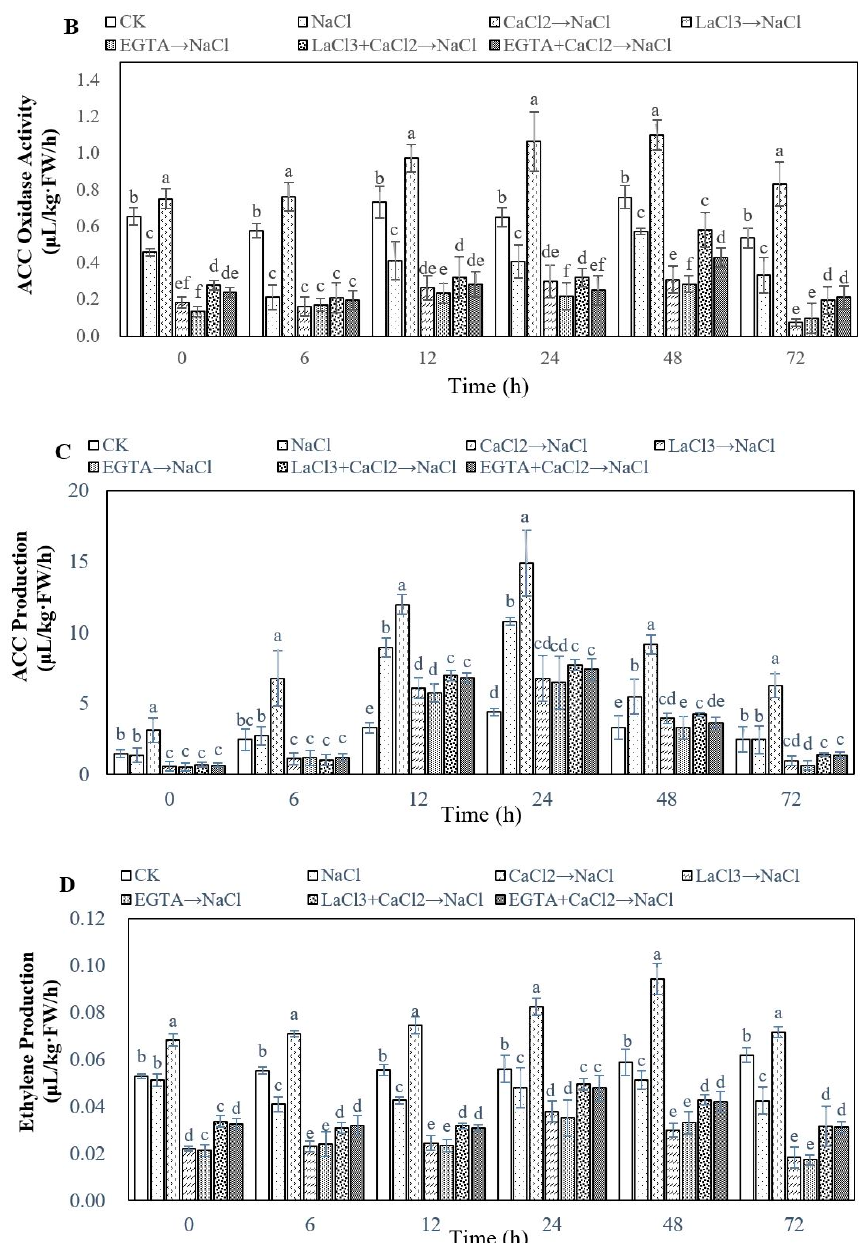
Figure 5. Effect of exogenous Ca 2+ on 1-aminocyclopropane-l-carboxylic acid synthase (ACS) activity ( A ), ACC Oxidase (ACO) activity ( B ), 1-aminocyclopropane-1-carboxylic acid (ACC) production ( C ), and ethylene production ( D ) in cucumber explants under salt stress at different times. The primary roots were removed from hypocotyl of five-day-old seedlings. Explants were incubated for five days with distilled water as control, meanwhile explants were incubated with 13 mM NaCl after being treated with distilled water or 10 µ M CaCl 2 , 500 µ M lanthanum chloride (LaCl 3 ), 100 µ M methylene glycol-bis (2-aminoethylether) -N,N,N (cid:48) ,N (cid:48) -tetraacetic acid (EGTA), 500 µ M LaCl 3 + 10 µ M CaCl 2 , and 100 µ M EGTA + 10 µ M CaCl 2 , respectively. Values are expressed as means ± SE ( n = 3), Bars with different lowercase letters were significantly different by Duncan’s multiple range test ( P <